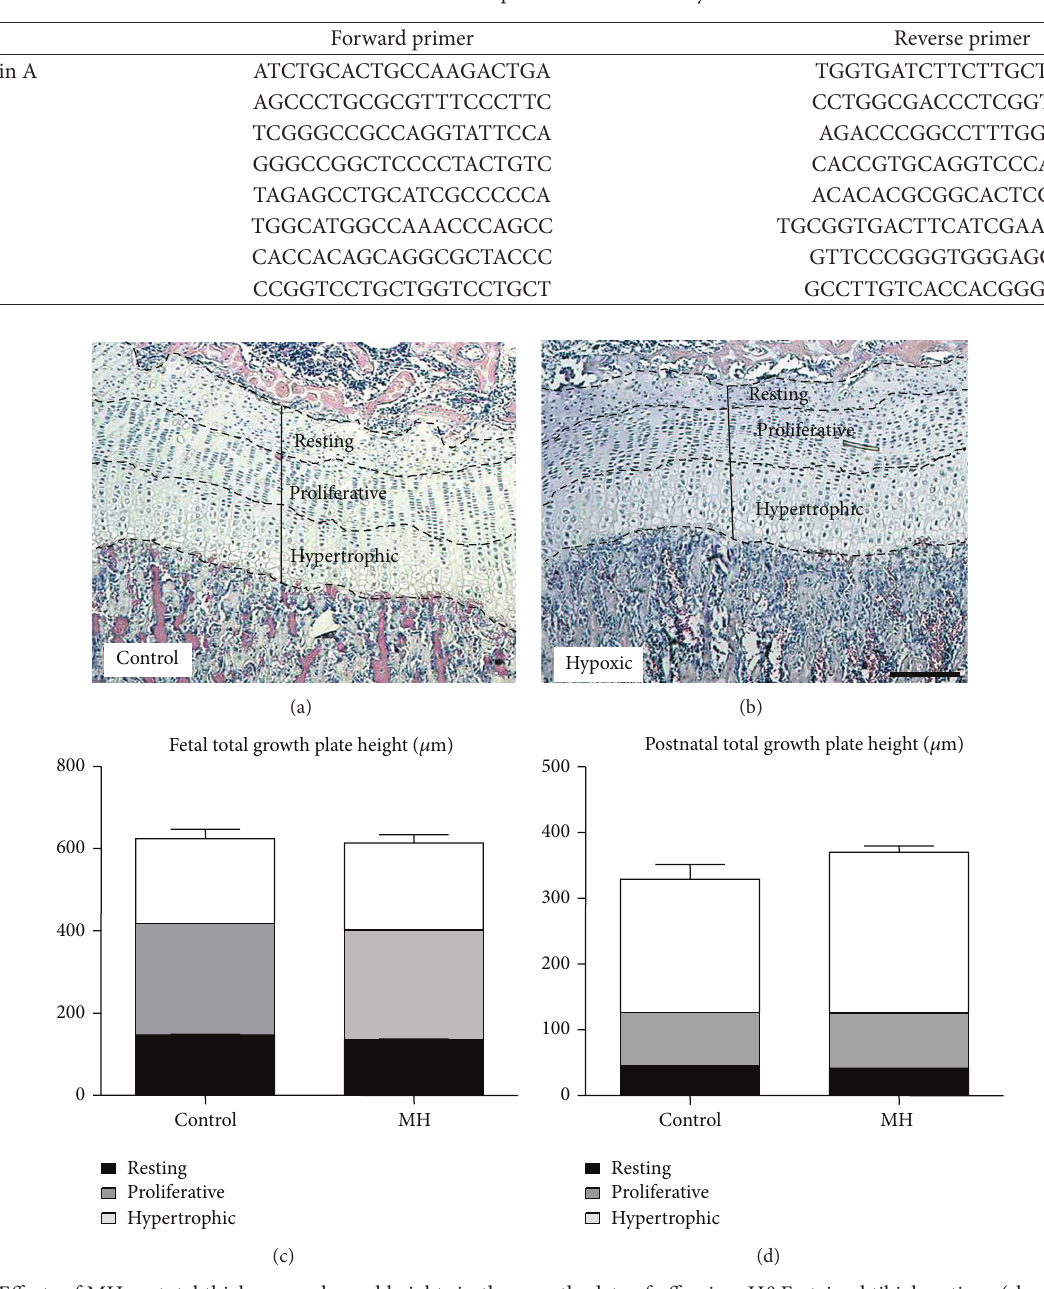
Figure 1: Effects of MH on total thickness and zonal heights in the growth plate of offspring. H&E-stained tibial sections (showing growth plate height) of 120d postnatal guinea pigs from a control (a) and a hypoxic (b) mother, respectively. The dashed lines in (a) and (b) arbitrarily separate the three individual growth plate zones. (c) Total growth plate thickness and zonal heights (resting, black bar; proliferative, grey bar; hypertrophic, white bar) of 62d gestation fetal guinea pigs from control and hypoxia-treated mothers. (d) Total growth plate thickness and zonal heights of 120d postnatal guinea pigs from control and hypoxia-treated mothers ( 𝑛 = 5 ). Scale bar in (a) = 250 𝜇 m and applies to